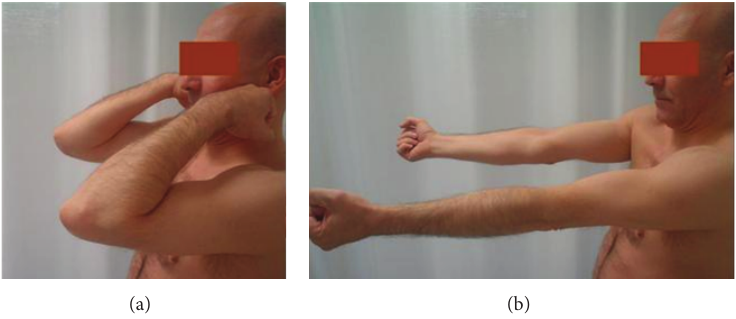
Figure 2: Appearance after one year with complete flexion and extension of the